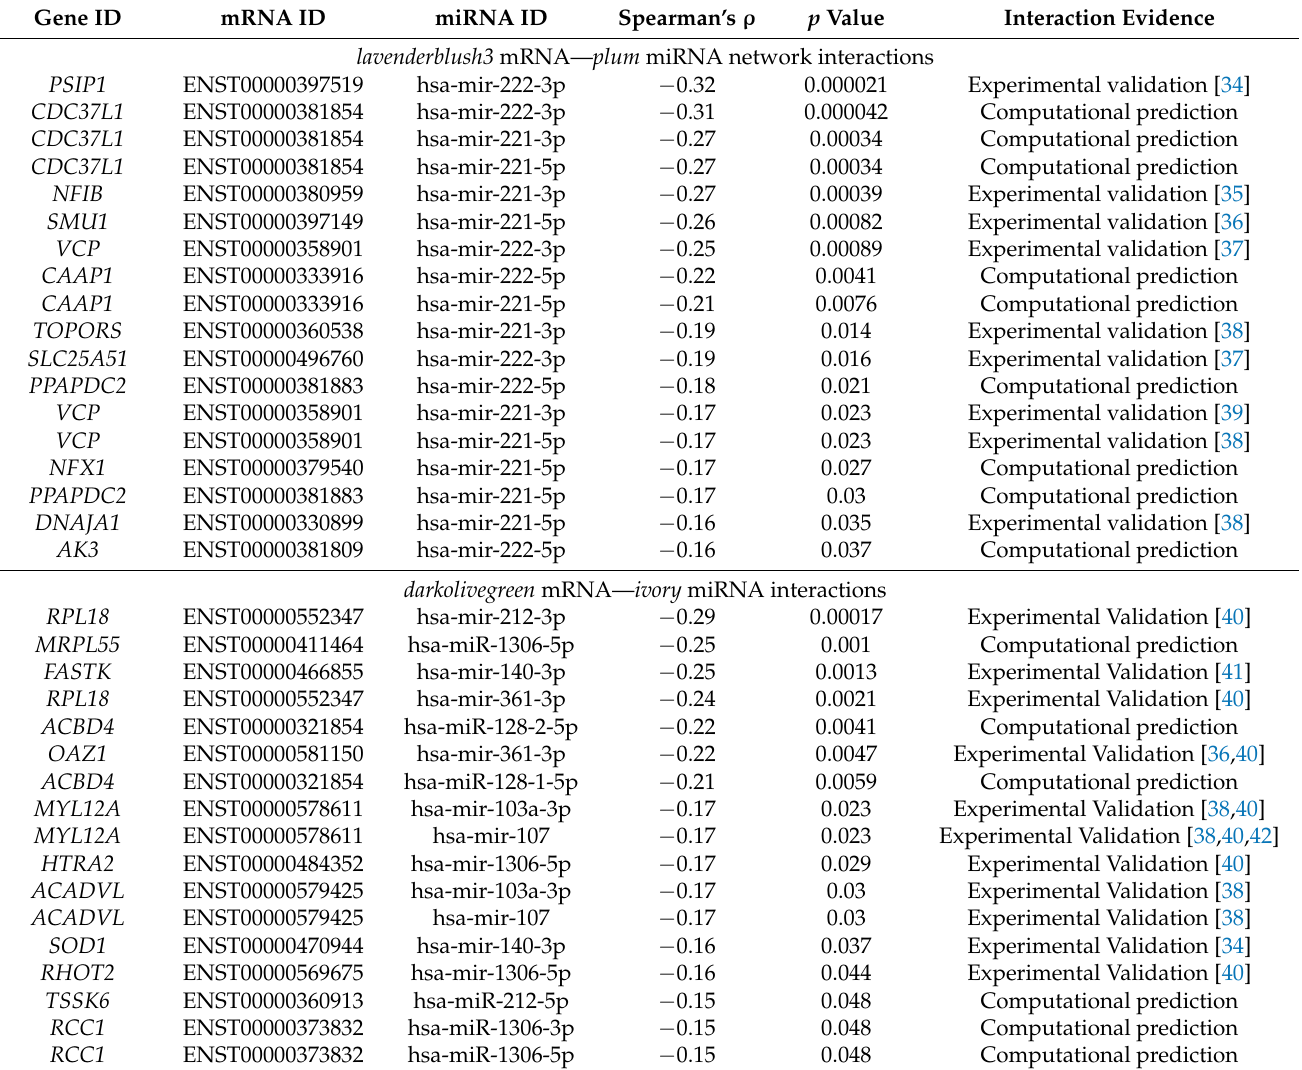
Table 1. Predicted and validated mRNA—miRNA network